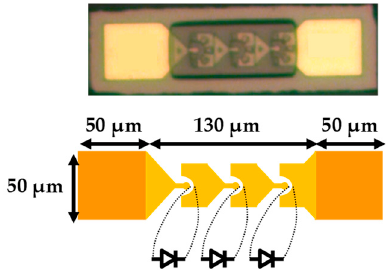
Figure 1. GaAs Schottky diode (three ‐ anodes in series).